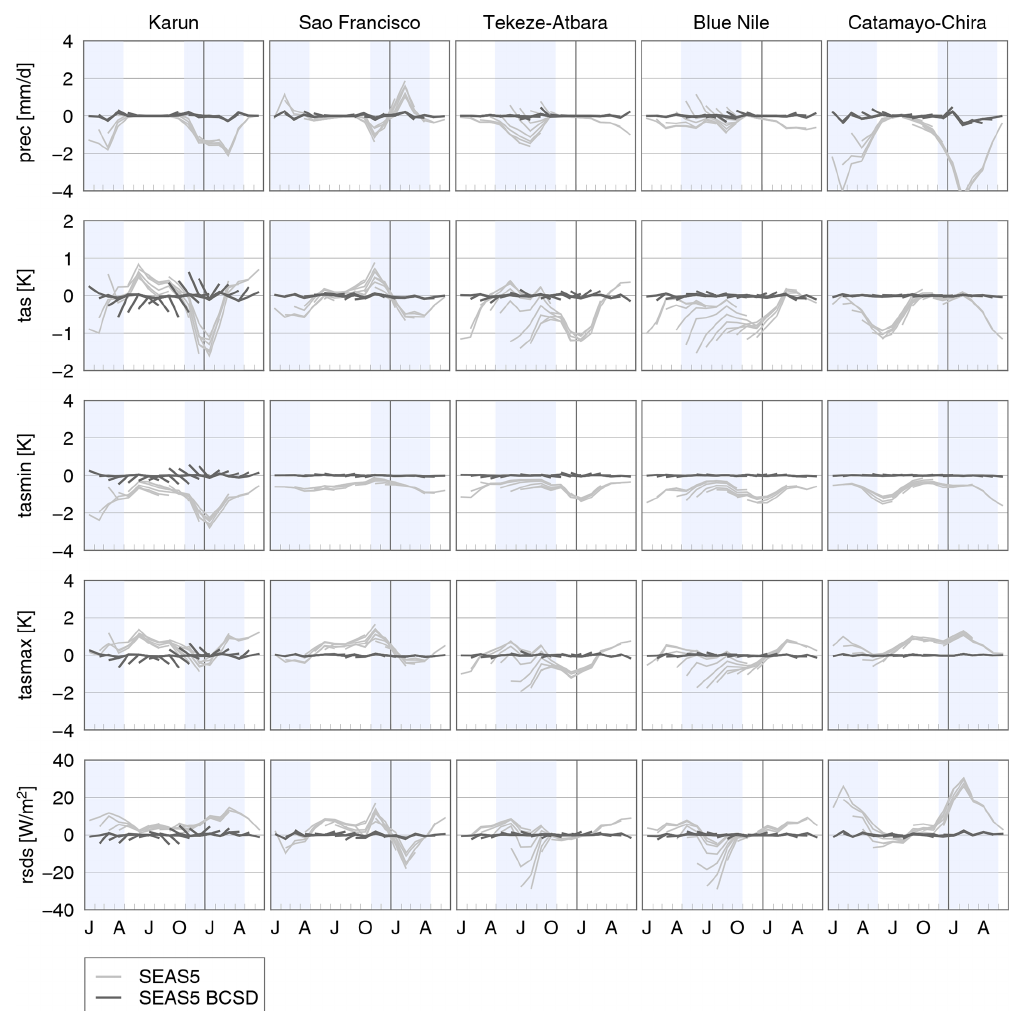
Figure 2. Bias of monthly (from top to bottom) precipitation (pr), average temperature (tas), minimum temperature (tasmin), maximum temperature (tasmax) and radiation (rsds) forecasts from SEAS5 (dashed lines) and SEAS5 BCSD (solid lines) with respect to ERA5-Land during the period 1981 to 2016 for all five study basins. The colors of the lines indicate the 12 different issue months from January to December. The vertical line between December and January indicates the end of the year; the values right of this line belong to the higher lead forecasts issued in September until December. The blue-shaded area depicts the 6 months of the rainy